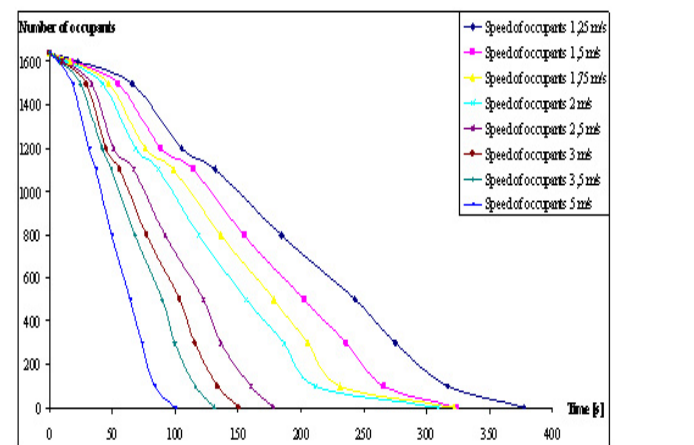
Figure 13 – Simulation results for realized cases Рис . 13 – Результаты моделерования симуляционных